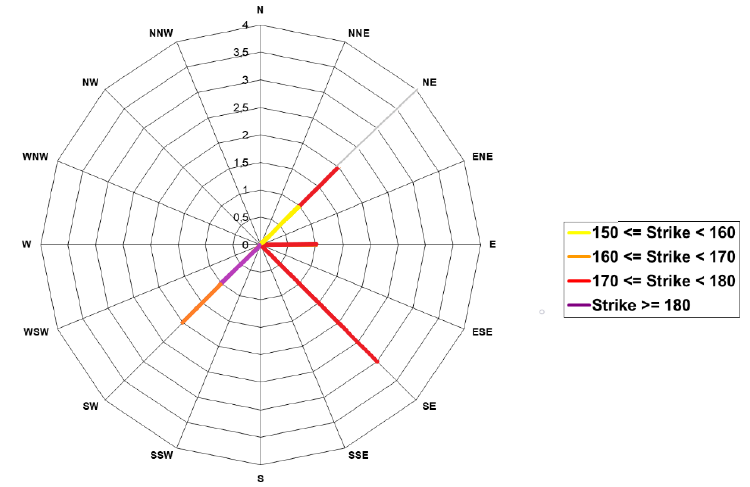
Figure 5. Rose diagram of the structural orientations of quartzite rocks in Thyspunt.